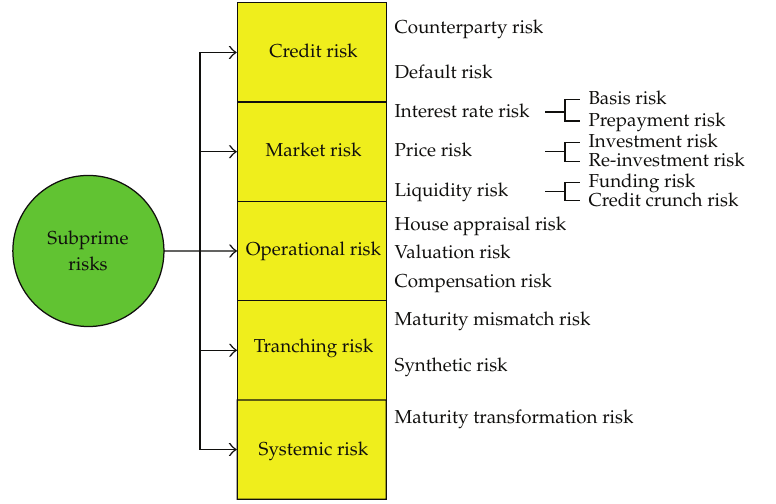
Figure 2: Diagrammatic overview of subprime